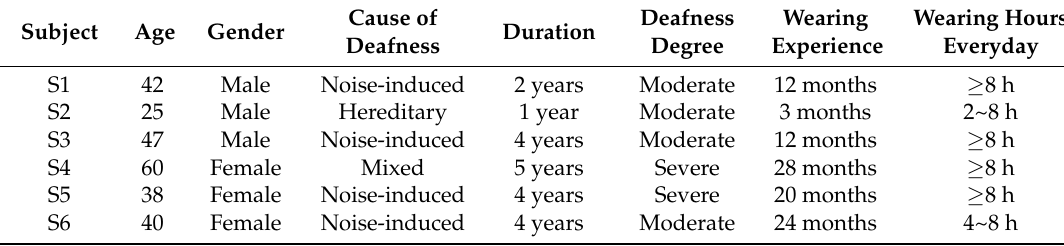
Table 1. General information of the subjects.